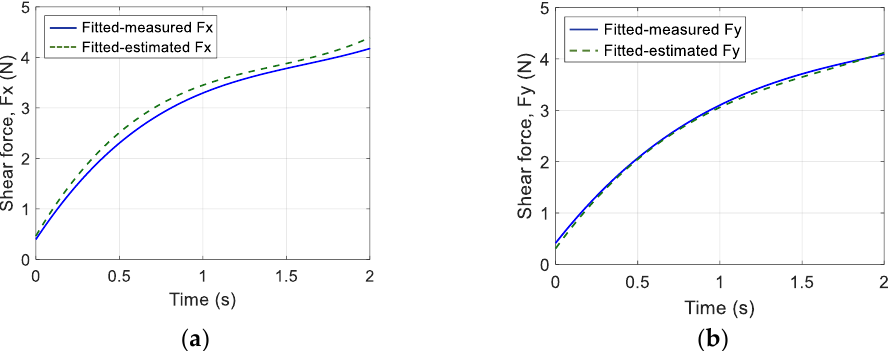
Figure 15. Measured and estimated shear force along the ( a ) x-axis and ( b ) y-axis.